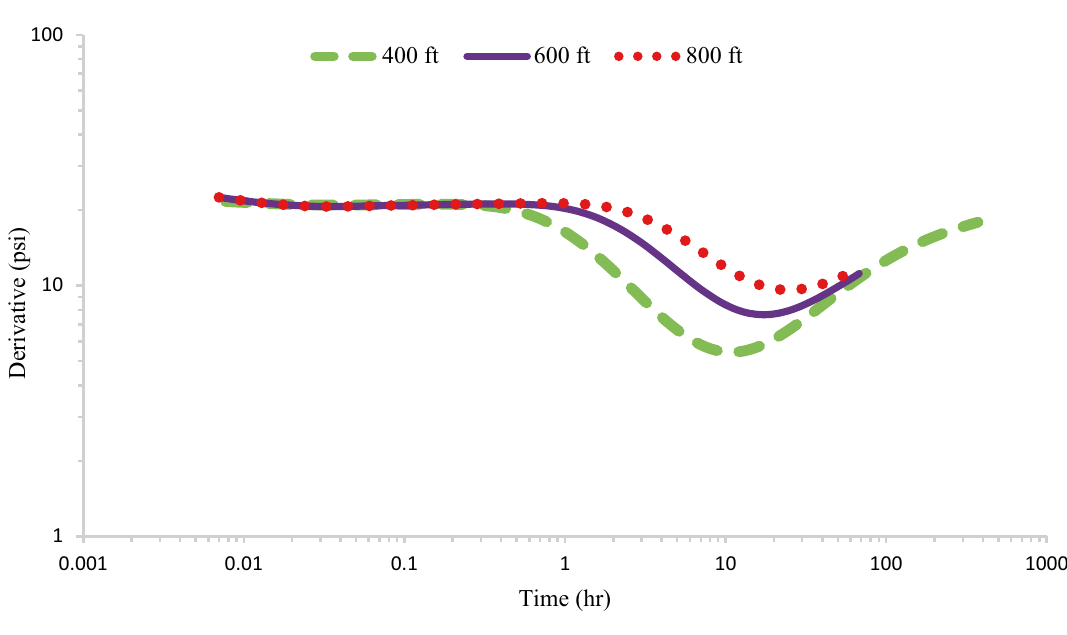
Fig. 5 Sensitivity analysis of scenario No. 1 on the well’s distance in homogenous